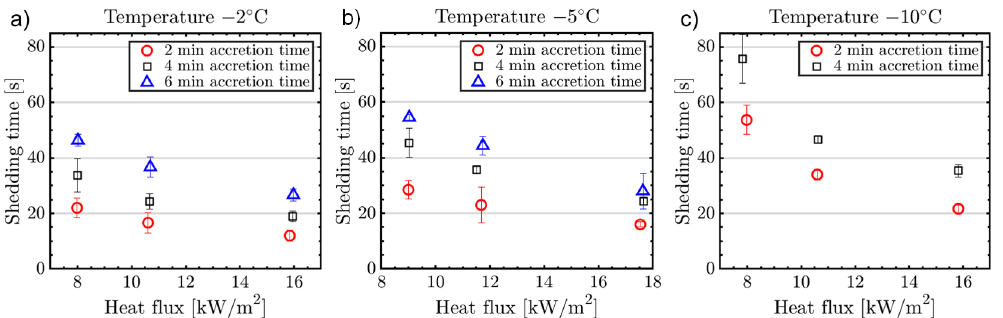
Figure 11. Shedding times of the conventional de-icing ice protection system for three different temperatures: T = − 2° ( a ), T = − 5° ( b ), and T = − 10° ( c ).